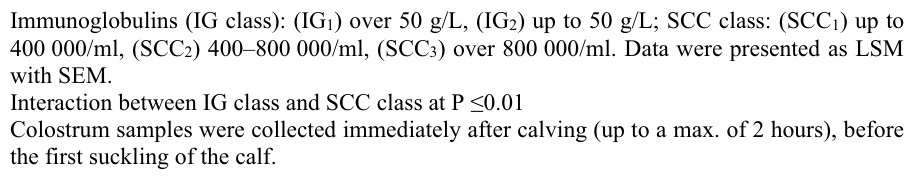
Figure 5. Interaction between the level of immunoglobulins and SCC as a factor influencing the level of whey proteins ( a ) LF, ALA, BLG, ( b ) IgG, IgM,